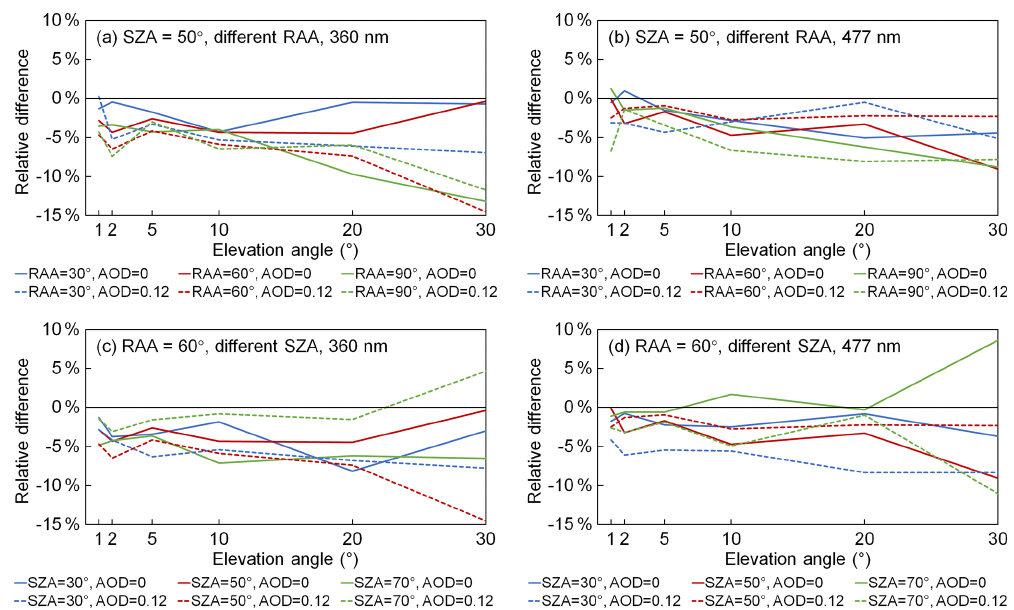
Figure 3. Relative differences of O 4 DSCDs at (a, c) 360nm and (b, d) 477nm simulated with a flat surface at 2650m compared to the O 4 DSCDs simulated with the pseudo-reality topography. Panels (a) and (b) show the results simulated with the same SZA of 50 ◦ and different RAAs (relative solar azimuth angles) of 30, 60, and 90 ◦ . Panels (c) and (d) show the results simulated with the same RAA of 60 ◦ and different SZAs of 30, 50, and 70 ◦ . Solid curves are the results simulated under aerosol-free conditions, and dashed curves are the results simulated with a box-shape profile with AOD = 0 . 12 and box height =